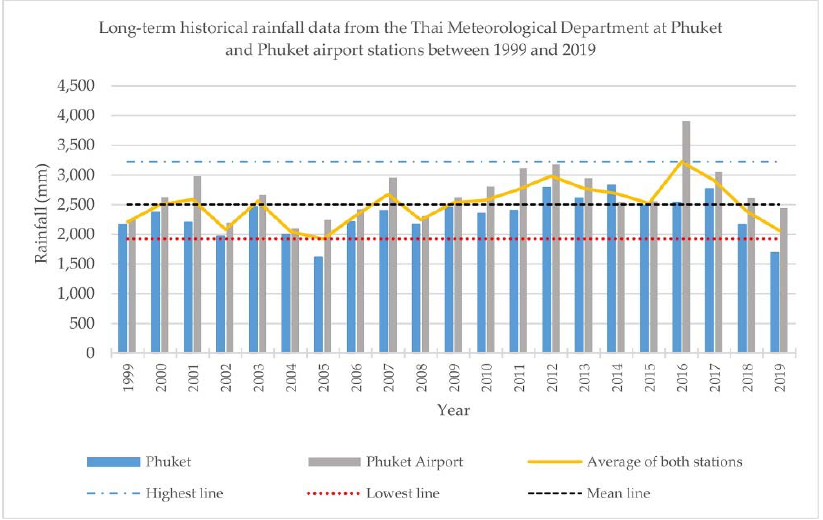
Figure 4. Long-term historical rainfall data at Phuket and Phuket Airport stations between 1999 and 2019.